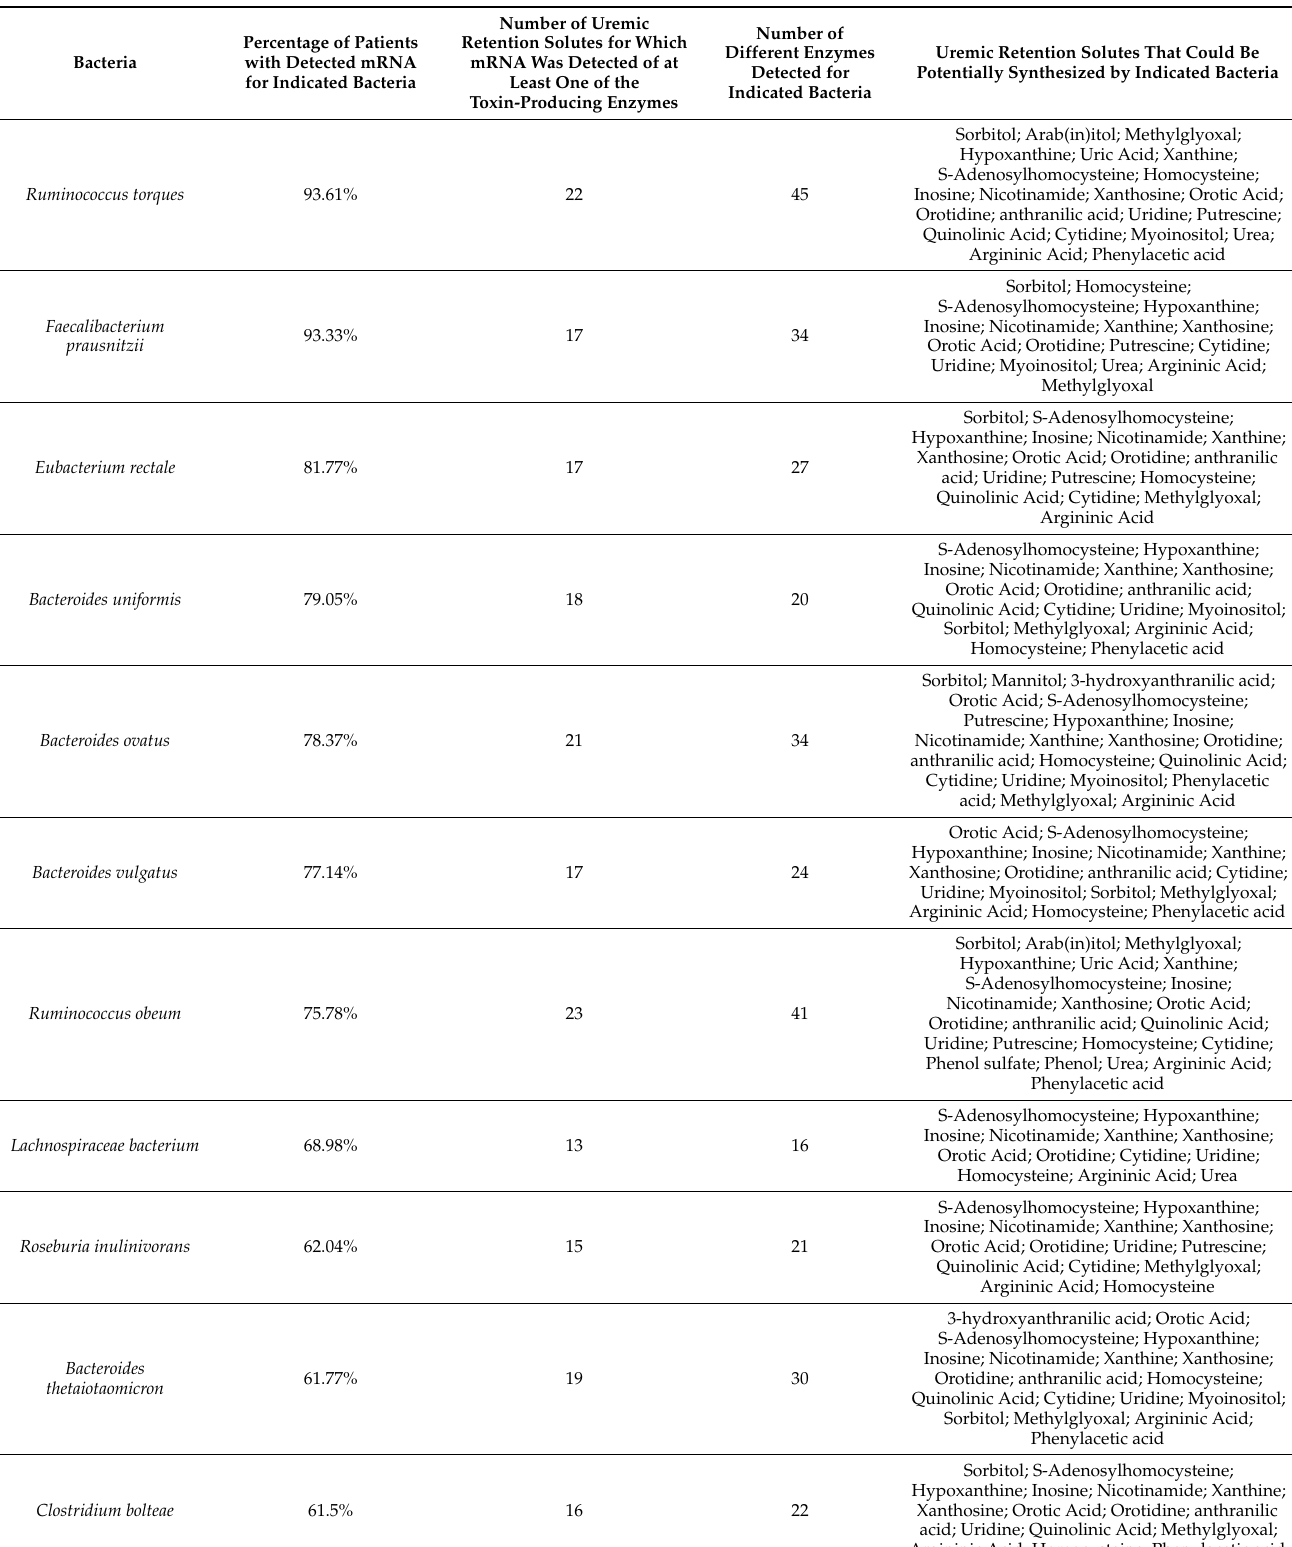
Table 5. Top 20 (in terms of occurrence) bacteria that metabolize uremic retention